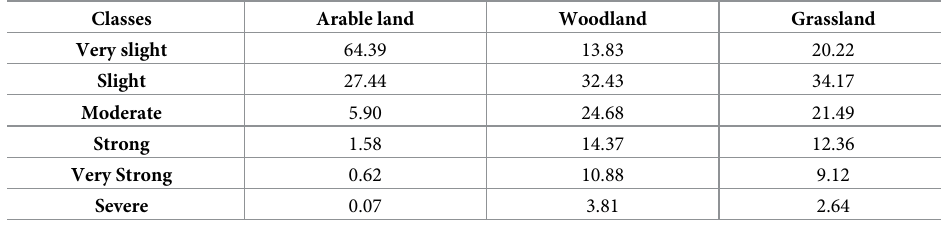
Table 5. Soil erosion proportions of different land-use types in the Qin River Basin (%).